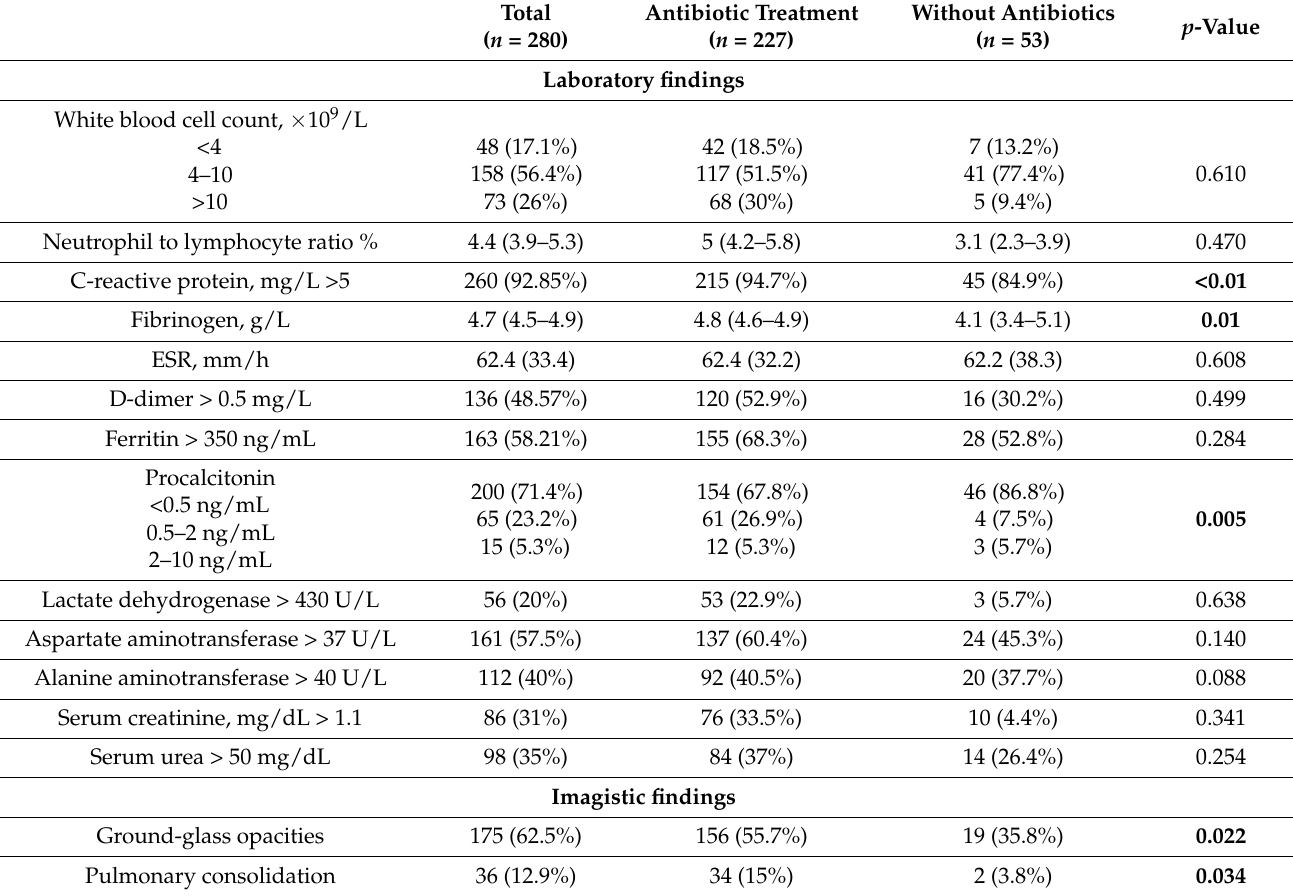
Table 2. Laboratory and imagistic